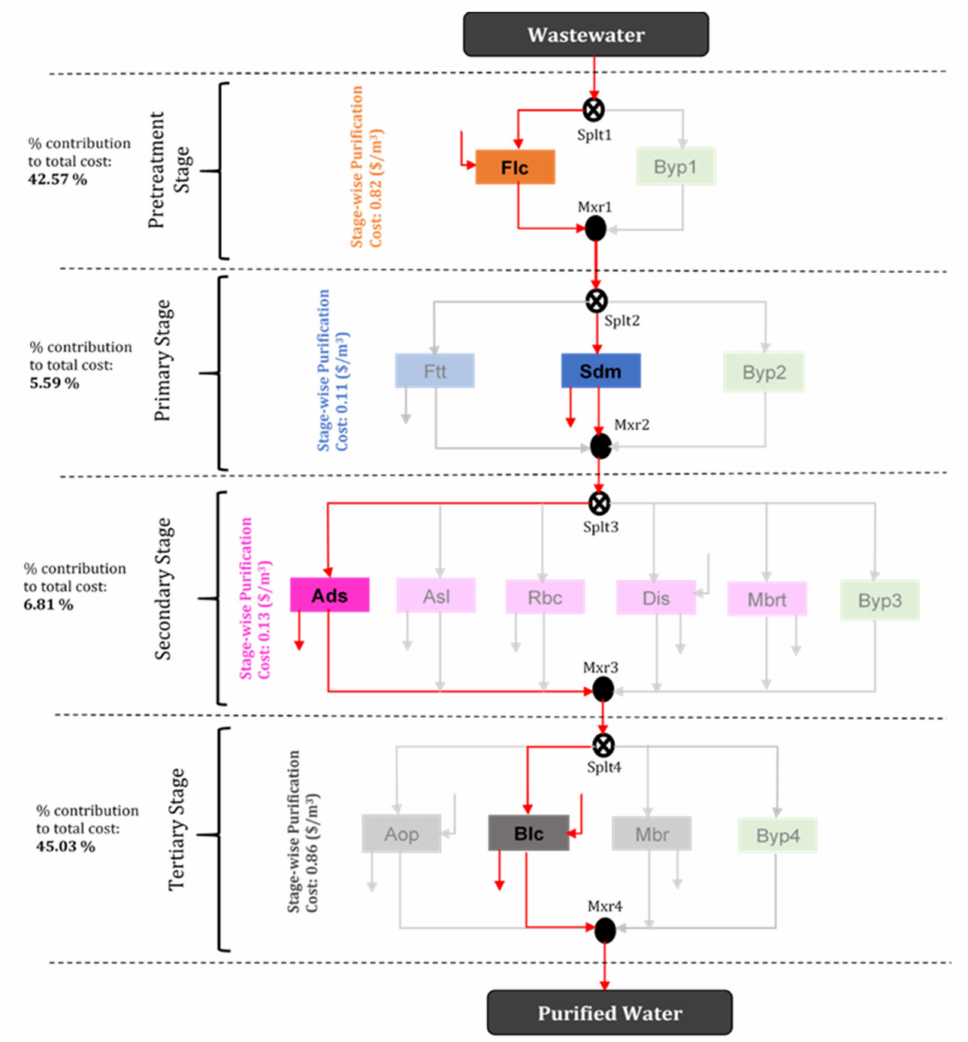
Figure 4. Optimal path selected for municipal WWT through GAMS. Flocculation (Flc), sedimentation (Sdm), adsorption (Ads), and bleaching (Blc) are the selected technologies. The tertiary stage contributes a percentage of 45.03% to the total cost, followed by the pretreatment, secondary, and primary stages,